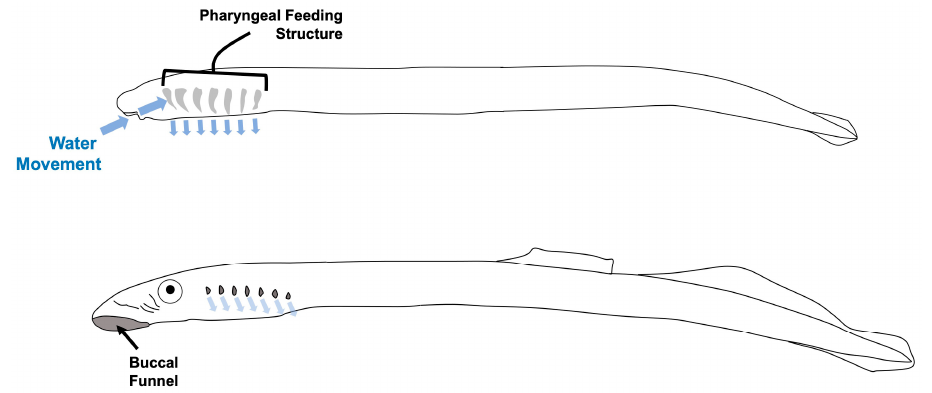
Figure 1. Lamprey ammocoete ( top ) and macropthalmia ( bottom ) morphology. Larval ammocoete move water over an internal pharyngeal pouch structure for microphagous filter-feeding. Eyed macropthalmia have a cup-like buccal funnel containing the mouth as well as several bicuspid teeth, an oral tooth plate, and tongue tooth, as well as seven pore-like gill openings on each side of the head. Table 1. Pairwise comparisons of treatment effects on E. coli concentrations by sampling day. Values are estimated differences to illustrate the extent of variation within each pairwise comparison. Pairwise differences considered significant after Bonferroni correction ( p < 0.0033) are highlighted in